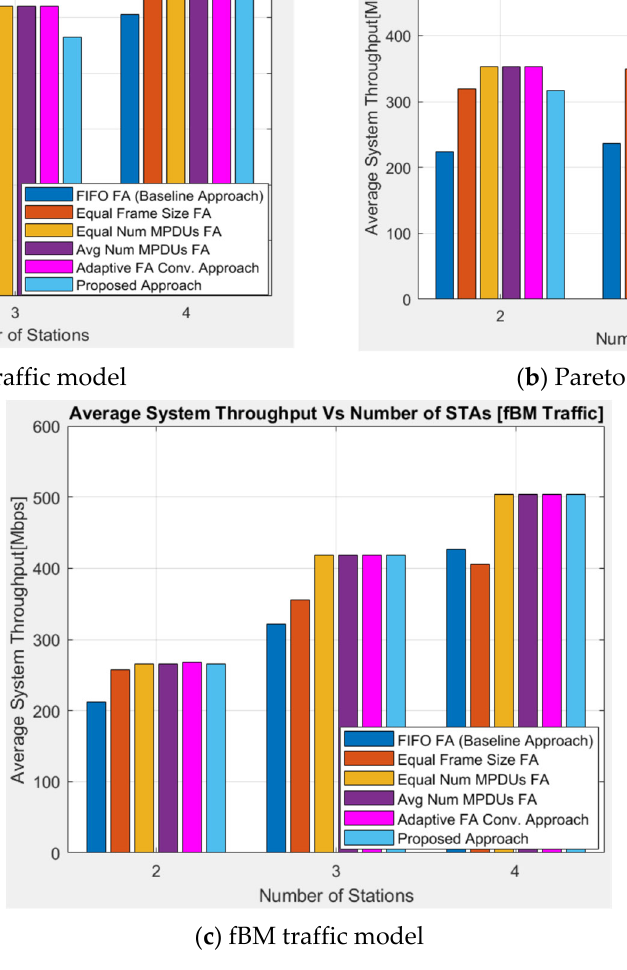
Figure 5. Performance of system throughput versus number of stations when the channel condition was SNR = 8 dB for the Weibull, Pareto, and fBM traffic